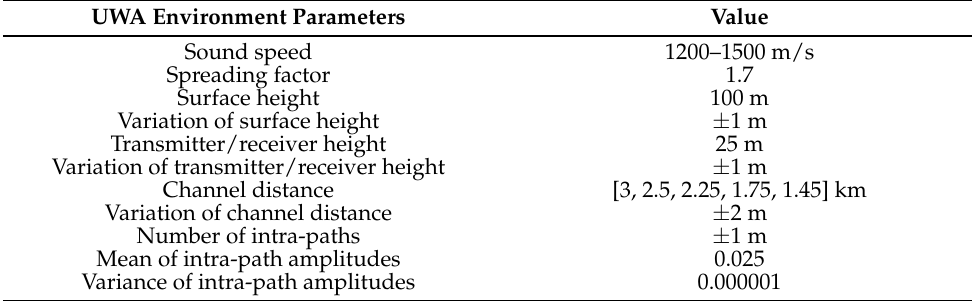
Table 1. Simulation parameters of UWA